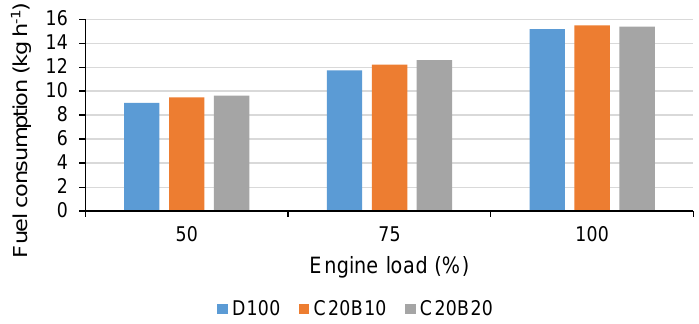
Figure 9. Mass fuel consumption in relation to engine load for all tested fuels.